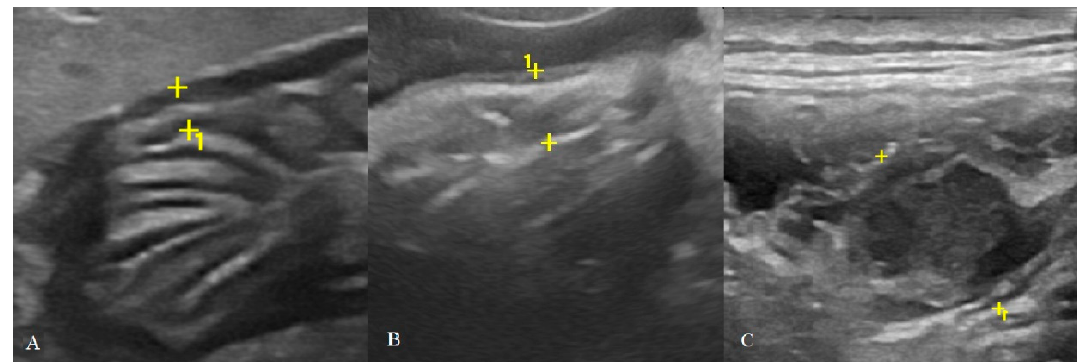
Figure 5. Classification of gastric wall layer definition on B-mode US: ( A ) normal: all the five layers are easily identified and thickness is normal (2.4 mm between the cursors in a HEA cat); ( B ) reduced: the identification of the layers is more di ffi cult and, in some portions, it may not be evident, in addition to a mild di ff use wall thickening (3.6 mm between the cursors in a INF cat); ( C ) absent: it is not possible to recognize the normal wall stratification and layer definition is lost. Here, a focal transmural mass (16.5 mm between the cursors in a HGAL cat) with mixed echogenicity is also